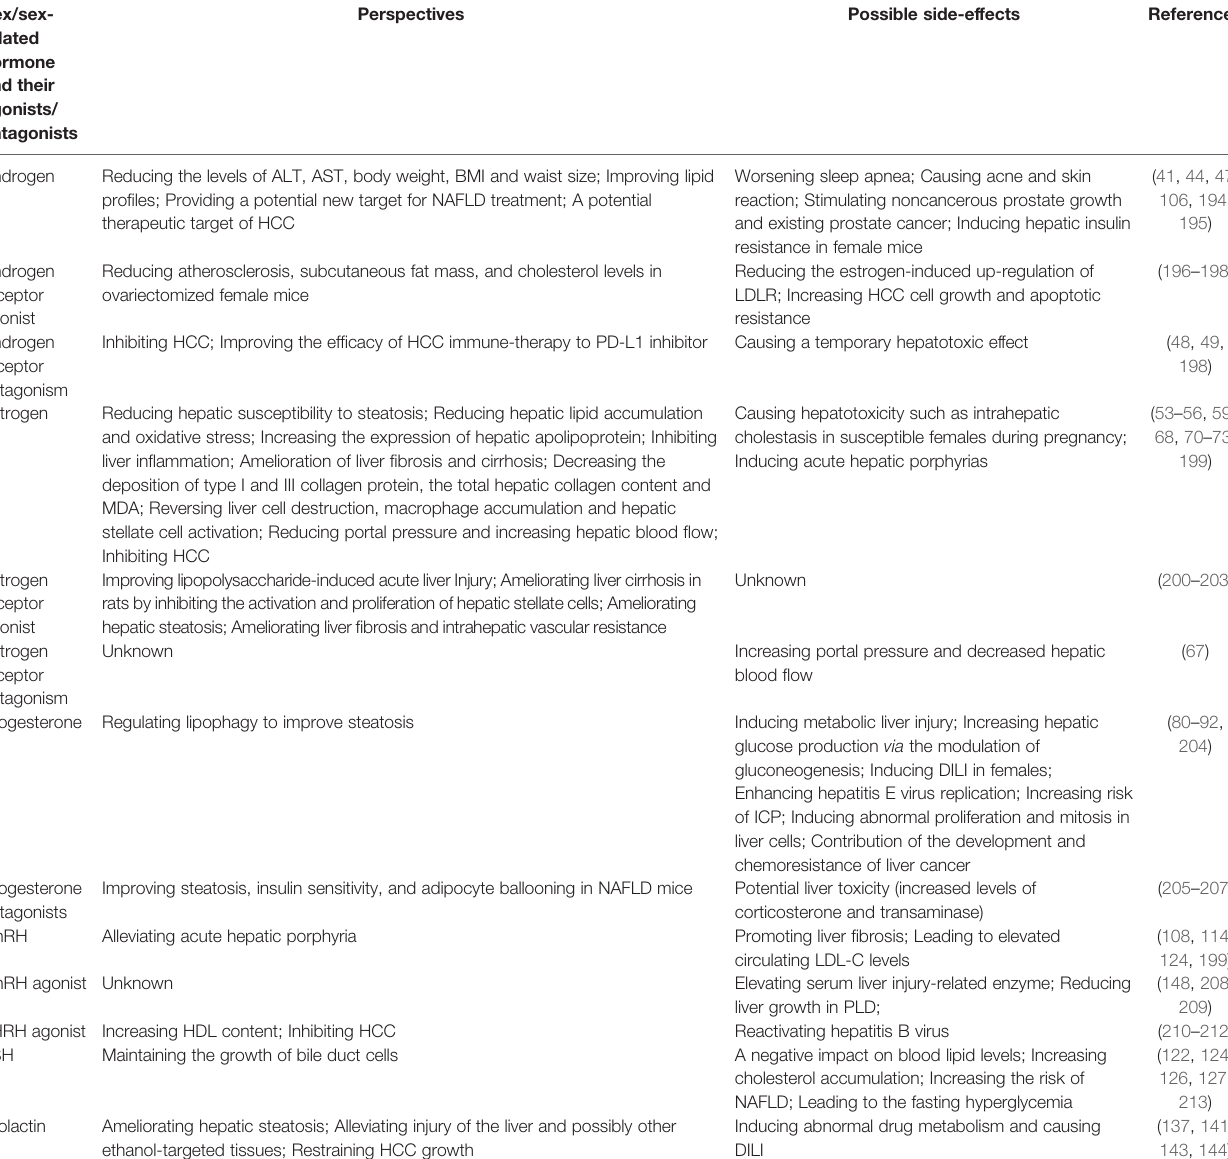
TABLE 3 | Perspectives and side-effects of sex/sex-related hormones or their agonists/antagonists in liver diseases